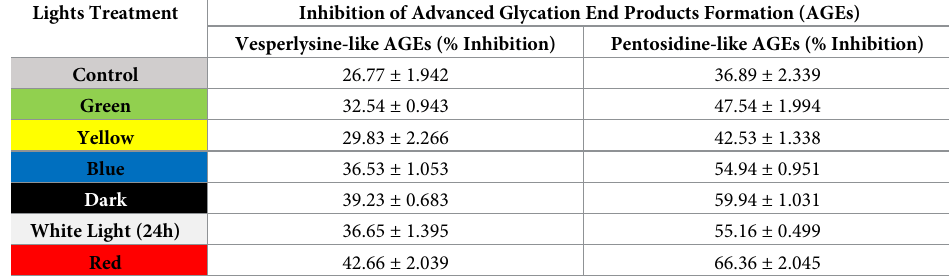
Table 1. % inhibition of advance glycation end products formation (AGEs) in callus culture of E . alba . Values rep- resent means ± standard errors from